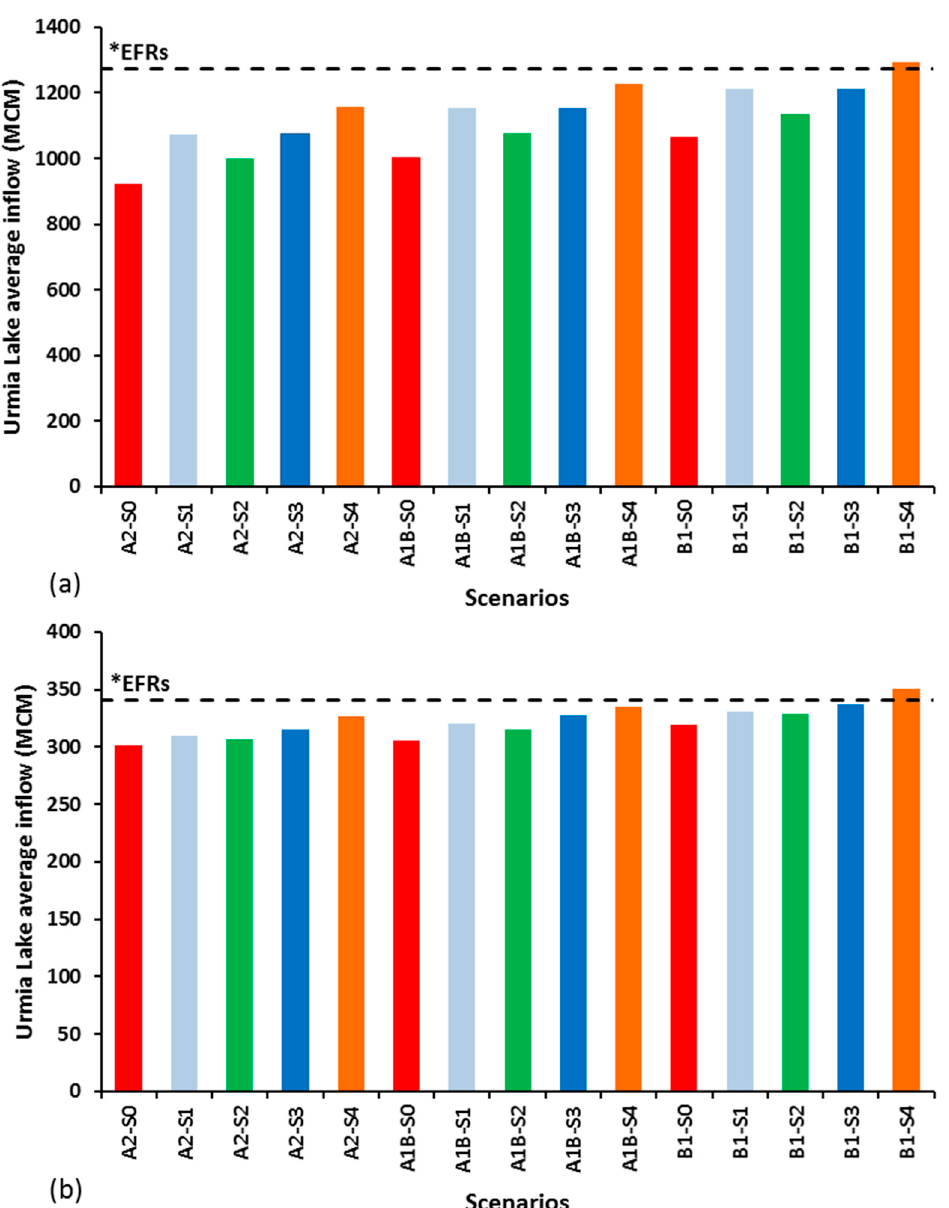
Figure 9. Average inflow to Urmia Lake under different scenarios (2015–2040): ( a ) from the Zarrinehrud River basin; and ( b ) from the Siminehrud River basin. EFRs: Environmental Flow Requirements.